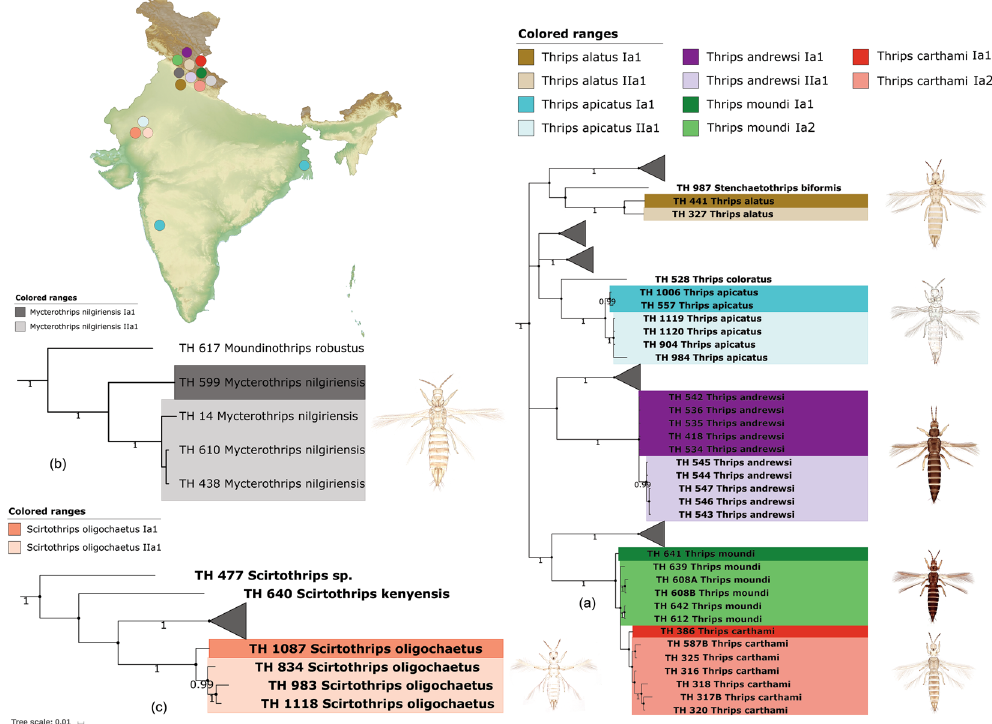
Figure 5. Pruned BA tree showing cryptic diversity of ( a ) Thrips alatus, Thrips apicatus, Thrips andrewsi, Thrips moundi, Thrips carthami ( b ) Myctrothrips nilgiriensis, and ( c ) Scirtothrips oligochaetus with MOTUs nomenclature and geographical locations. Photographs used here were taken by the first author (K. T.). The original template of the topographic map used here is copied under the following attribution: created by Yug (Own work) [CC BY-SA 3.0 (http://creativecommons.org/licenses/by-sa/3.0)], via Wikimedia Commons; file URL: https://upload.wikimedia.org/wikipedia/commons/b/b9/Wikimaps_atlas-India-topographic_map-color- blank.jpg; page URL: https://commons.wikimedia.org/wiki/File%3AWikimaps_atlas-India-topographic_map-